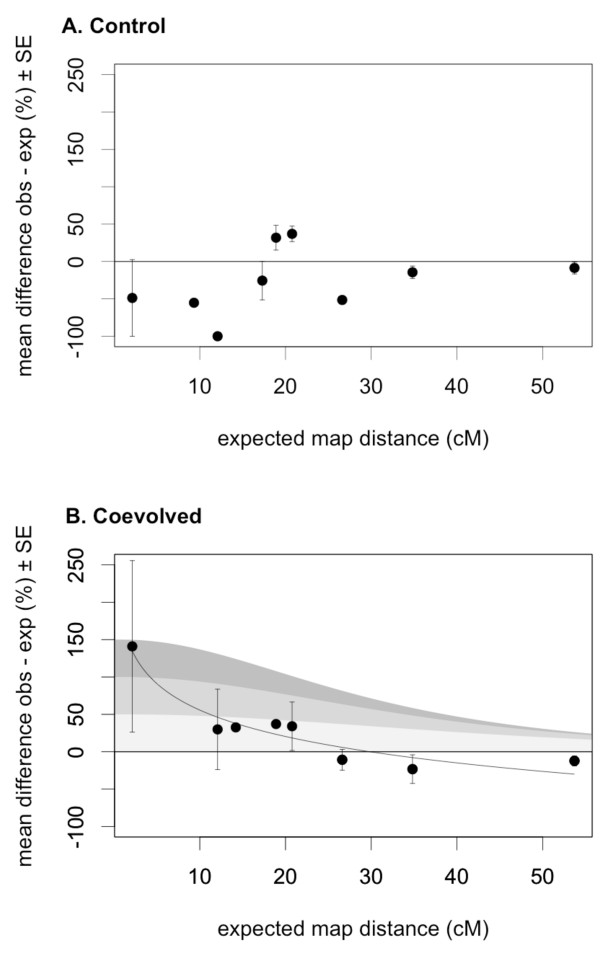
Mean relative difference between observed and expected map distance against the expected map distance. The figure shows all data, i.e. all recombination measurements in all intervals of all lines (35 distinct recombination measurements in control lines, and 24 distinct recombination measurements in coevolved lines). Recombination frequencies were transformed into map distances. Map distances were averaged over interval and line. a, The relative difference does not deviate from a non-difference line and does not correlate with interval length (linear regression, n = 9, F1, 7 = 0.986, P = 0.354), suggesting that recombination in the control treatment did not deviate from expected recombination. b, In the coevolving lines a significant logarithmic relationship was observed (linear regression, n = 8, F1, 6 = 64.310, P < 0.001, R2 = 0.915), which might indicate an overall increase in recombination. The grey areas represent the theoretical change in observed recombination rate, in terms of percentage, in the cases of a 50% (light grey), 100% (medium grey) and a 150% (dark grey) genome-wide increase in actual map distance. Kosambi's map function was used to convert map distances into recombination frequencies. The areas illustrate that for large intervals it might be hard to detect a change in recombination frequency, even in the case of a substantial increase in the actual map distance.